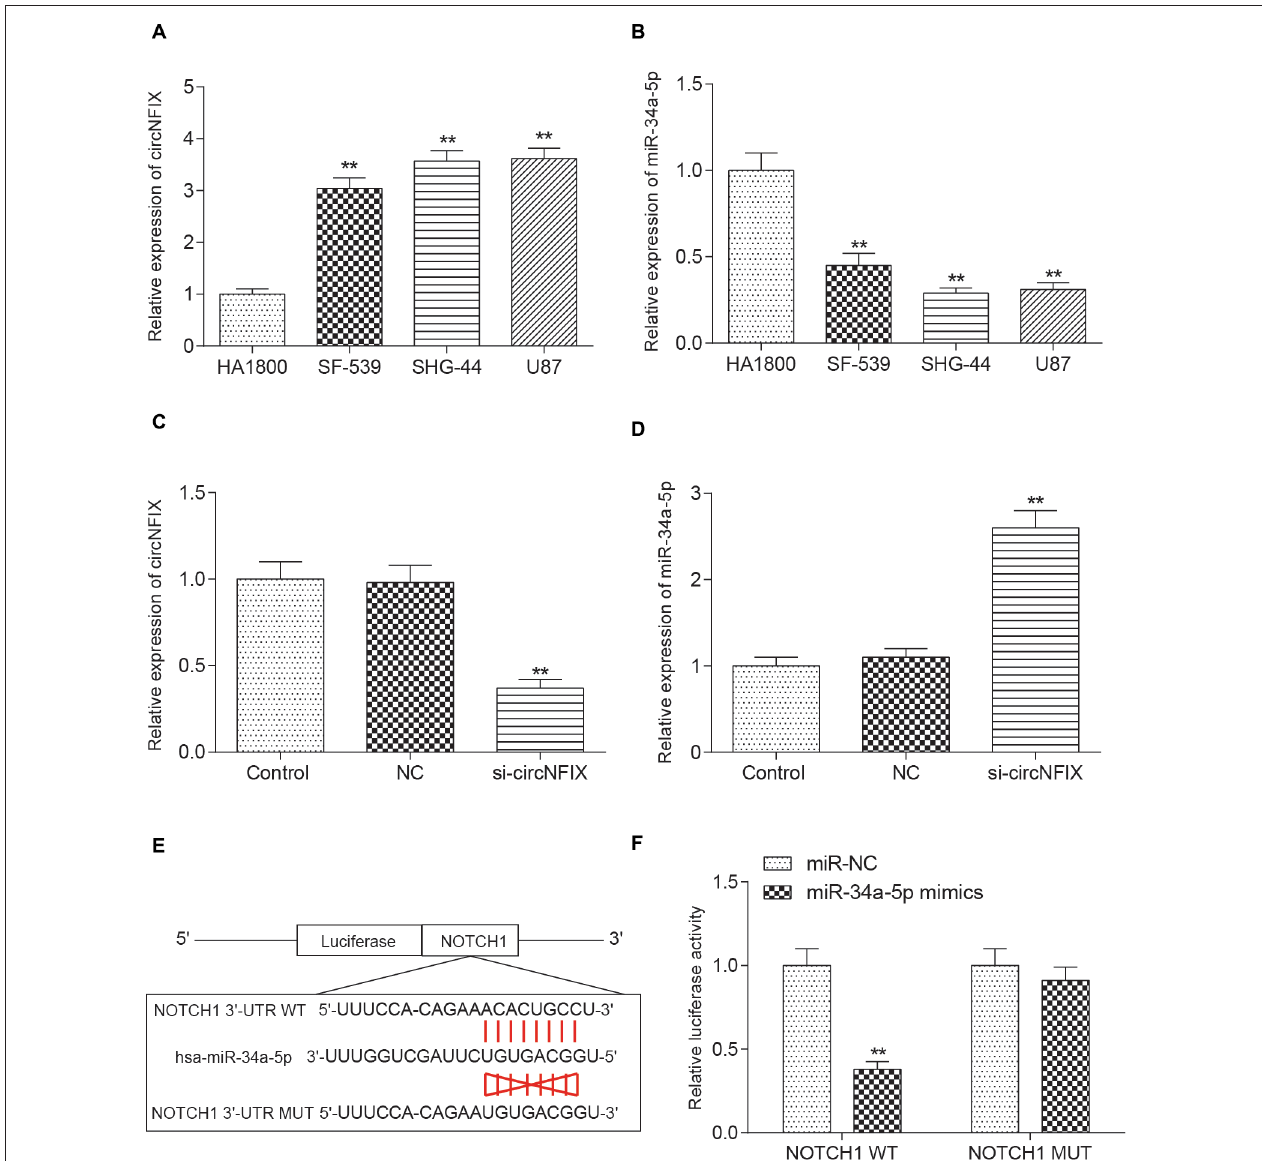
FIGURE 4 | CircNFIX and miR-34a-5p presented differential expression in glioma cells. (A) QRT-PCR analyzed the expression of circNFIX in the glioma cell lines SF539, SHG-44 and U87 and the normal cells HA1800. (B) QRT-PCR analyzed the expression of miR-34a-5p. (C) The expression of circNFIX after transfection with si-circNFIX. (D) The expression of miR-34a-5p after transfection with si-circNFIX. (E) TargetScan predicted that NOTCH1 3’-UTR WT had a binding site for hsa-miR-34a-5p. (F) The luciferase reporter assay analyzed the target relationship between NOTCH1 and miR-34a-5p. ∗∗ P < 0.01 compared with the NC